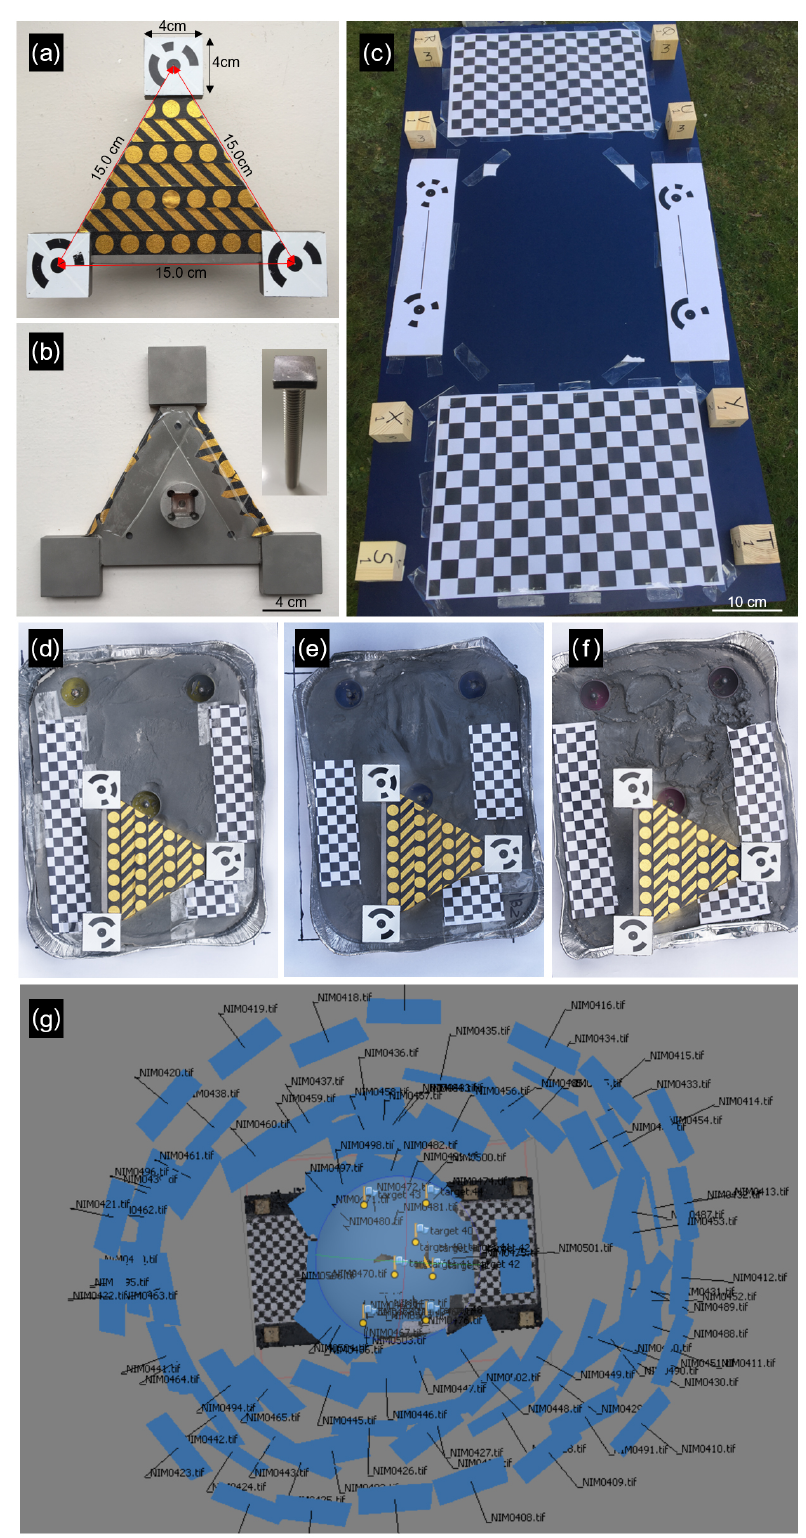
Figure 1. The experimental set-up. (a) The CRS top view with scale shown and (b) underside with the square-headed bolt (inset). (c) The experimental platform with markers and wooden blocks used to calculate the horizontal and vertical error. (d, e, f) The simulated platform and (g) example of the camera positions for image